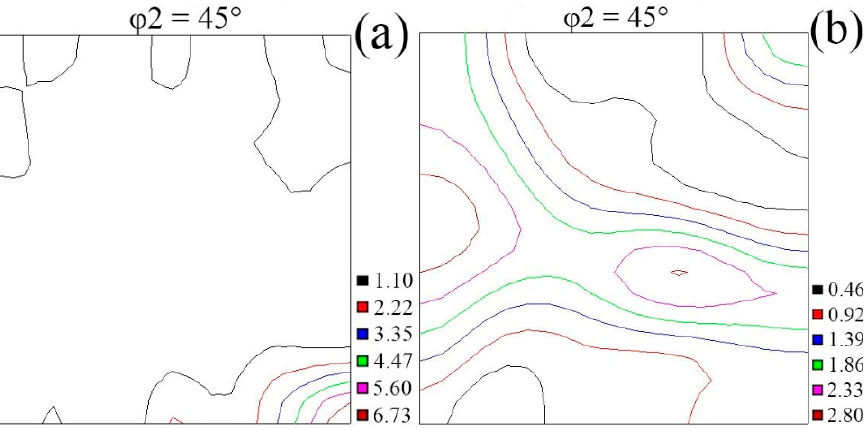
Figure 14. Macro-texture ( φ 2 = 45°section of ODF) of samples rolled with different lubrication condition ( a ) 700 °C—78%, ( b ) 700 °C—78%—1.